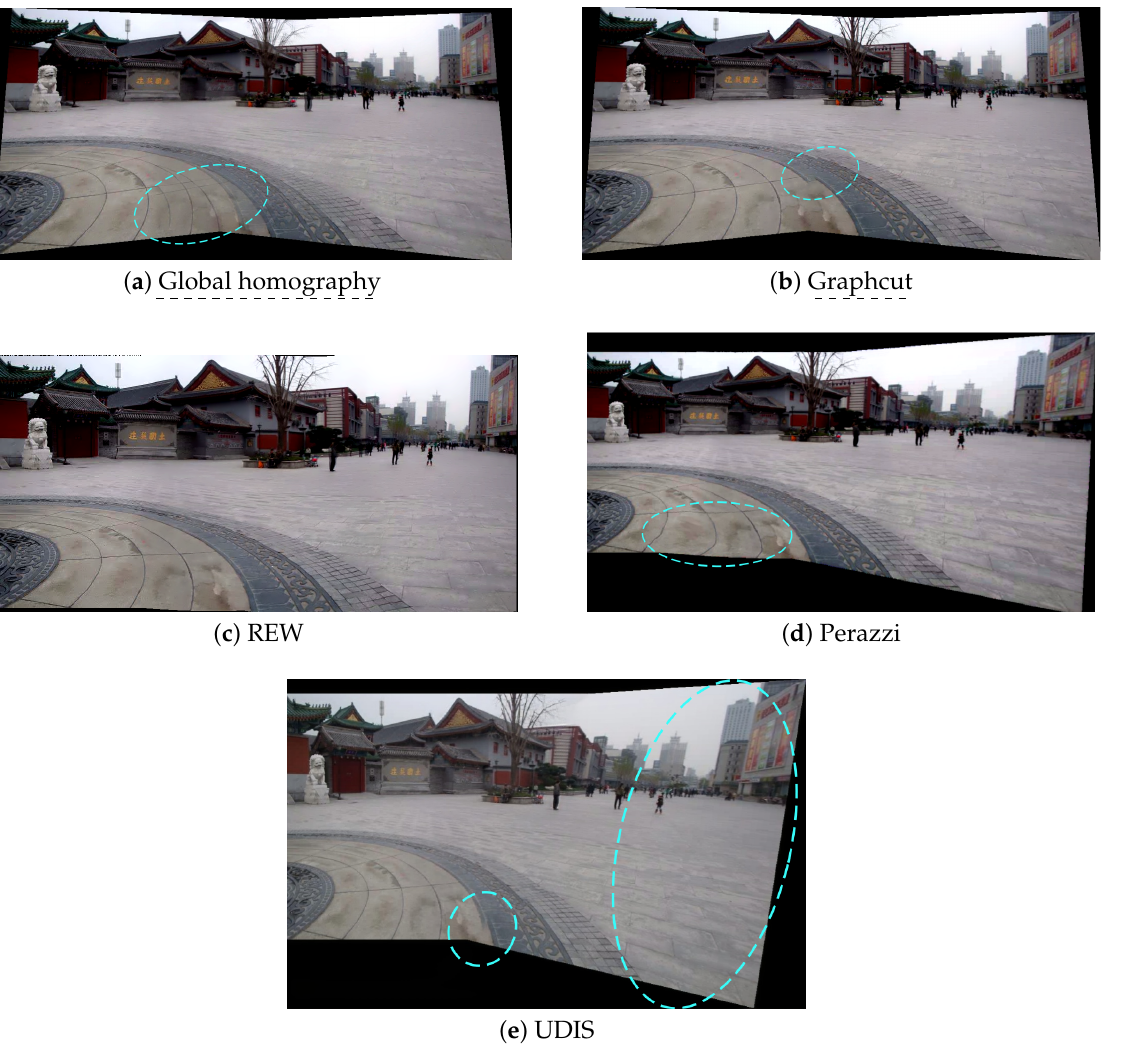
Figure 4. The resulting panoramas in the temple scenario. Blue dashed circles point to the main issues. ( a ) Global homography: background blur, duplicated elements, projective distortions. ( b ) Graphcut: no background blur, but strong discontinuities and some projective distortions. ( c ) REW: perfect stitching. ( d ) Perazzi: perfect alignment, but slight distortions. ( e ) UDIS: no background blur, but a few discontinuities and some projective